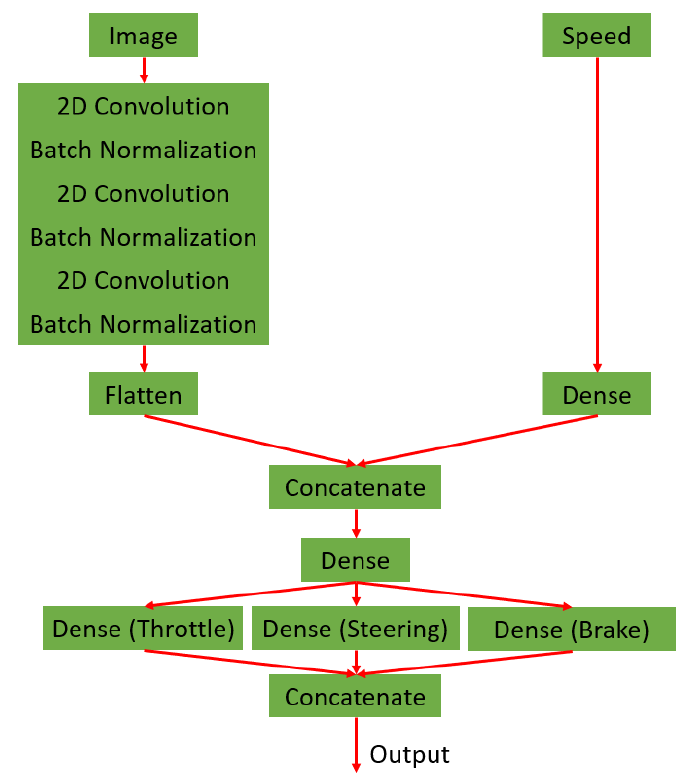
Figure 7. Actor architecture of the DDPG.